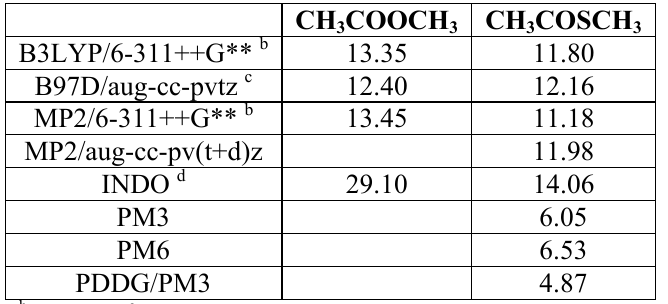
Table 4. Torsion barrier energies relative to the cis conformation in the gas phase a